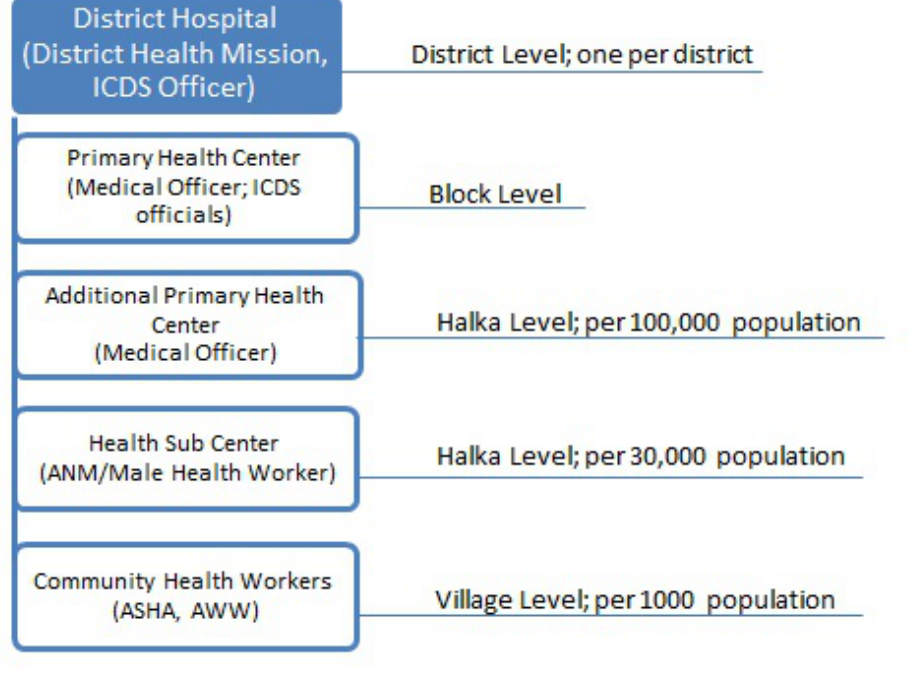
Figure 1. Public health system structure in India. The manpower available at each tier and administrative level of each type of health facility are shown. Each tier acts as a referral unit for the tier below. The district hospital services the facilities below with necessary support, resources, and essentials. Halka is a collection of villages, and Block is a collection of